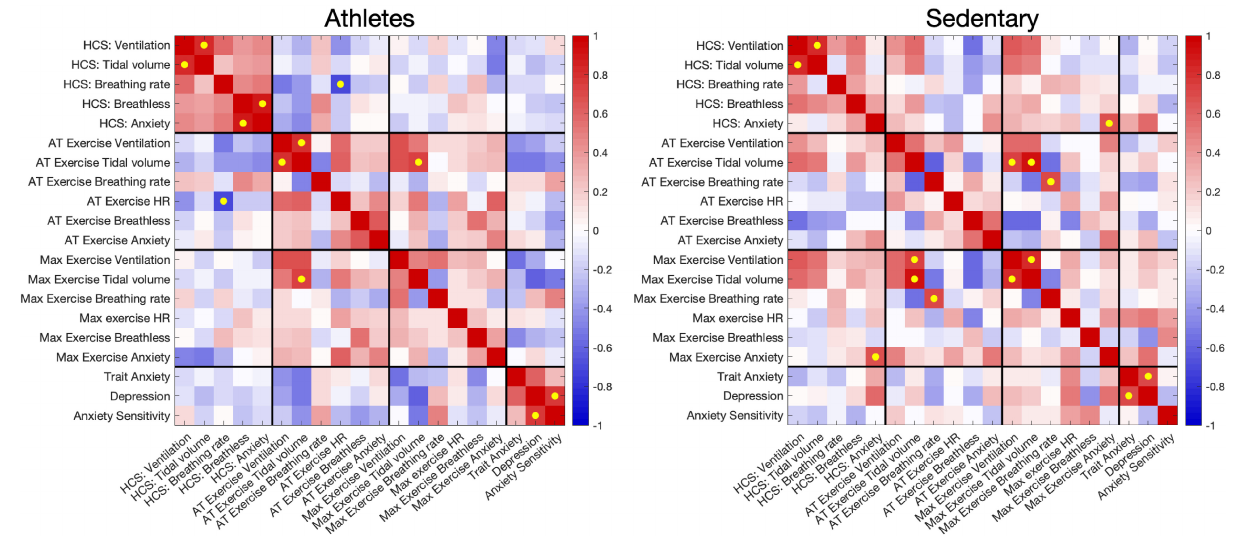
FIGURE 2 | Correlations between ventilatory and perceptual hypercapnic chemosensitivity measures, exercising ventilation, heart rate and perceptions, and affective measures of anxiety, depression and anxiety sensitivity. Correlations were performed separately for athletes and sedentary groups. Yellow dots denote correlations that have p < 0.05 and are FDR-corrected for multiple comparisons. HCS = Hypercapnic chemosensitivity; AT = Anaerobic threshold, determined using the V-slope method (Wasserman et al., 1973; Beaver et al.,